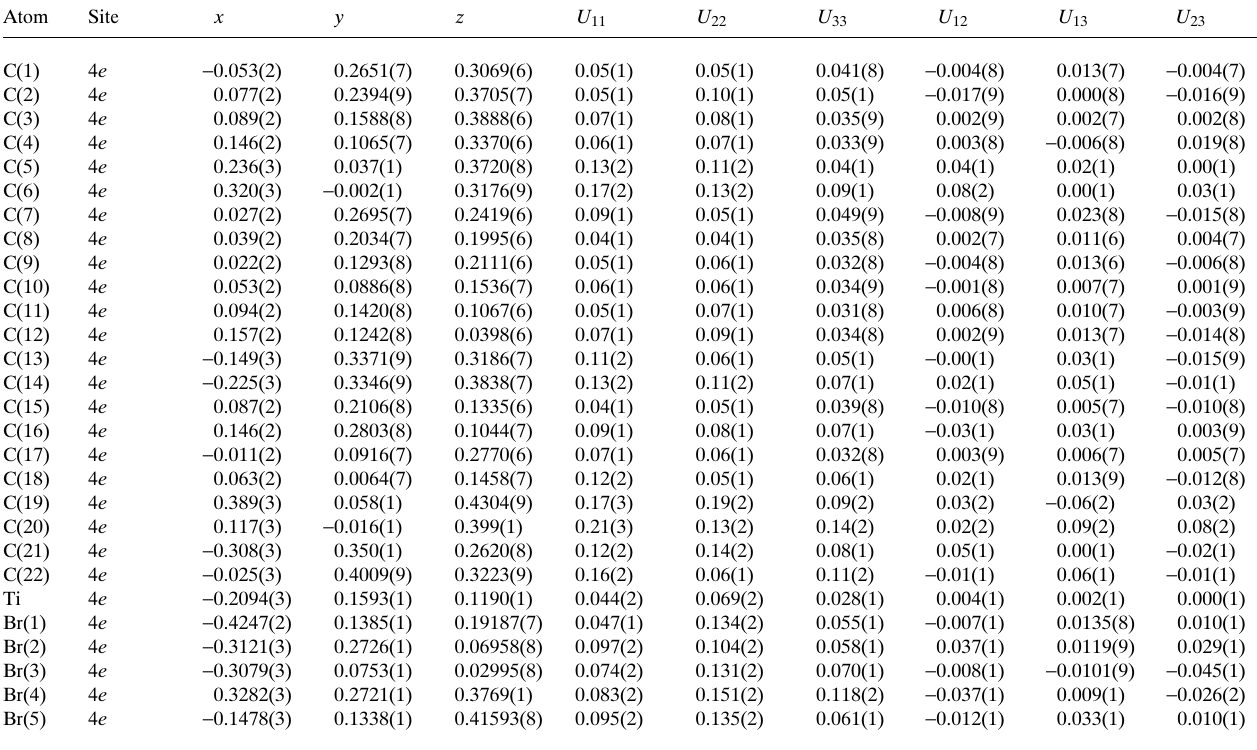
Table 6. Atomic coordinates and displacement parameters (in Å 2 )